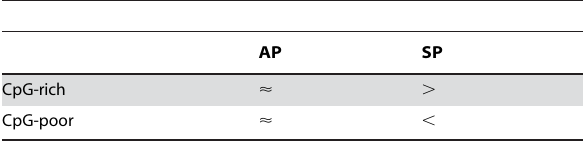
Table 4. The promoter usage in the SCs compared with the negative controls.